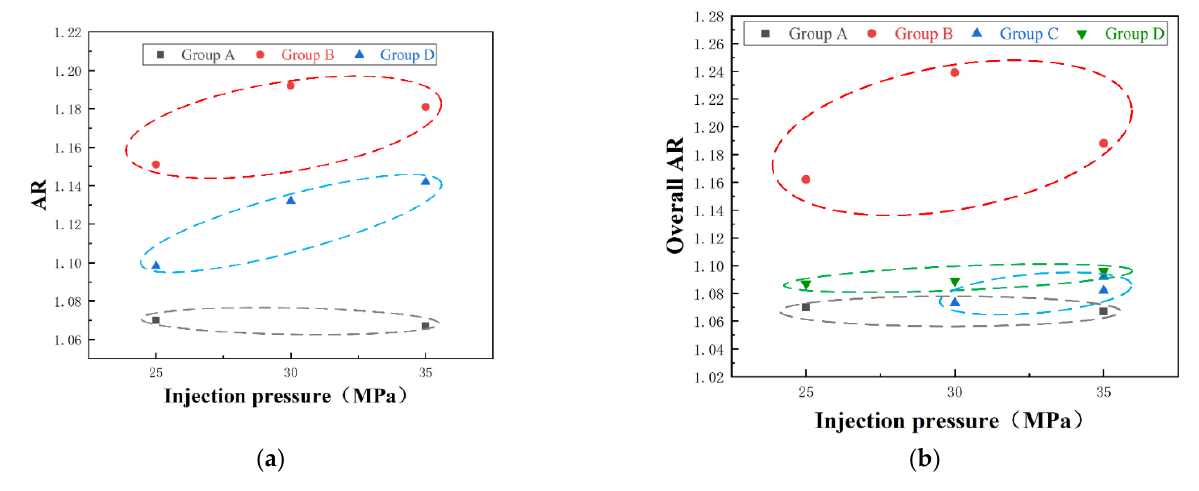
Figure 11. ( a ) The AR of longitudinal fractures in group A, B and D; ( b ) the overall AR of different rock specimens.